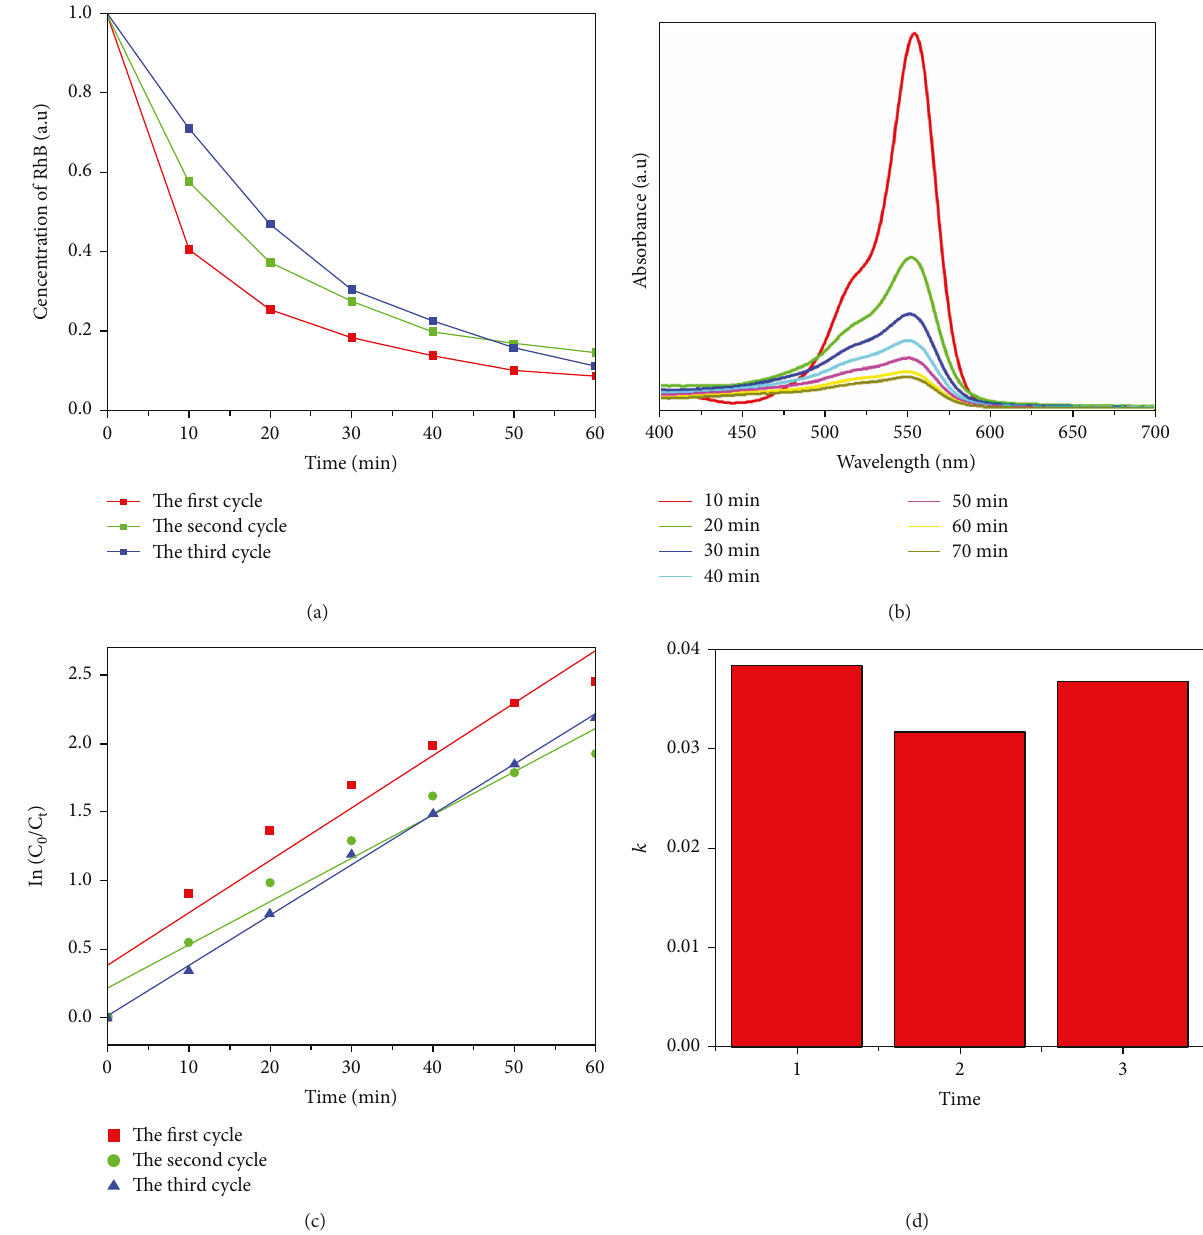
Figure 5: (a) The cycle test of TCF15 for photocatalytic degradation of RhB under UV light irradiation. (b) Absorption spectral changes of RhB solution under UV light irradiation in the presence of TCF15. (c) The degradation kinetic data of RhB under UV light irradiation at di ff erent cycle times. (d) Degradation rate K value data calculated from the peak gradually decreases due to the increase of TiO 2 load amount from TCF05 to TCF20. These results indicate Figure 2 is XRD patterns and Raman spectra of TCF05, that the loaded photocatalyst on the biomass carbon fi ber is TCF10, TCF15, and TCF20 samples. In Figure 2(a), the a mixture of anatase and rutile TiO . Figure 2(b) shows the 2 peaks sited at approximately 25.21, 37.81, 47.81, 53.91, Raman spectra of TiO /carbon fi ber composites. Besides the 2 55.11, 62.81, 68.81, 70.51, 75.31, and 27.48 o are correspond- peaks of carbon fi ber, the Raman shift peaks located at 144, 400, 518, and 640 cm − 1 are related to the Eg, B1g, A1g, and ing to the crystal plane (101), (004), (200), (105), (211), (204), (116), (220), and (215) of anatase TiO Eg Raman vibrations of anatase TiO and (110) . It illustrates that 2 2 of rutile TiO there are a large number of TiO , respectively. The broad di ff raction peak nanoparticles on the bio- 2 2 located at around 20 o is related to amorphous carbon, and mass carbon fi ber, which is consistent with XRD results.